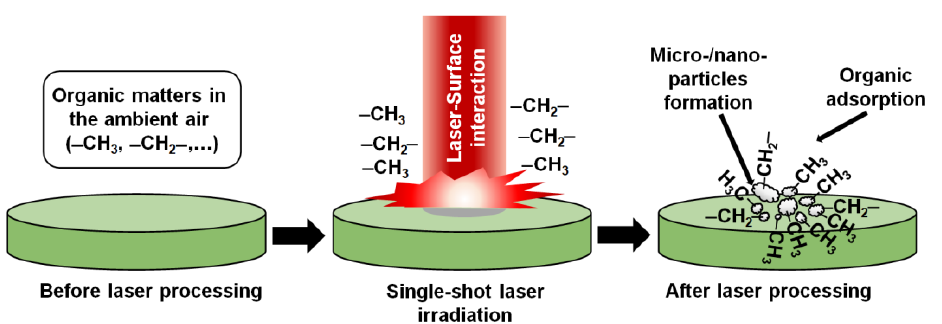
Figure 5. Mechanisms of the wettability conversion on the single-shot laser-treated aluminum surface.